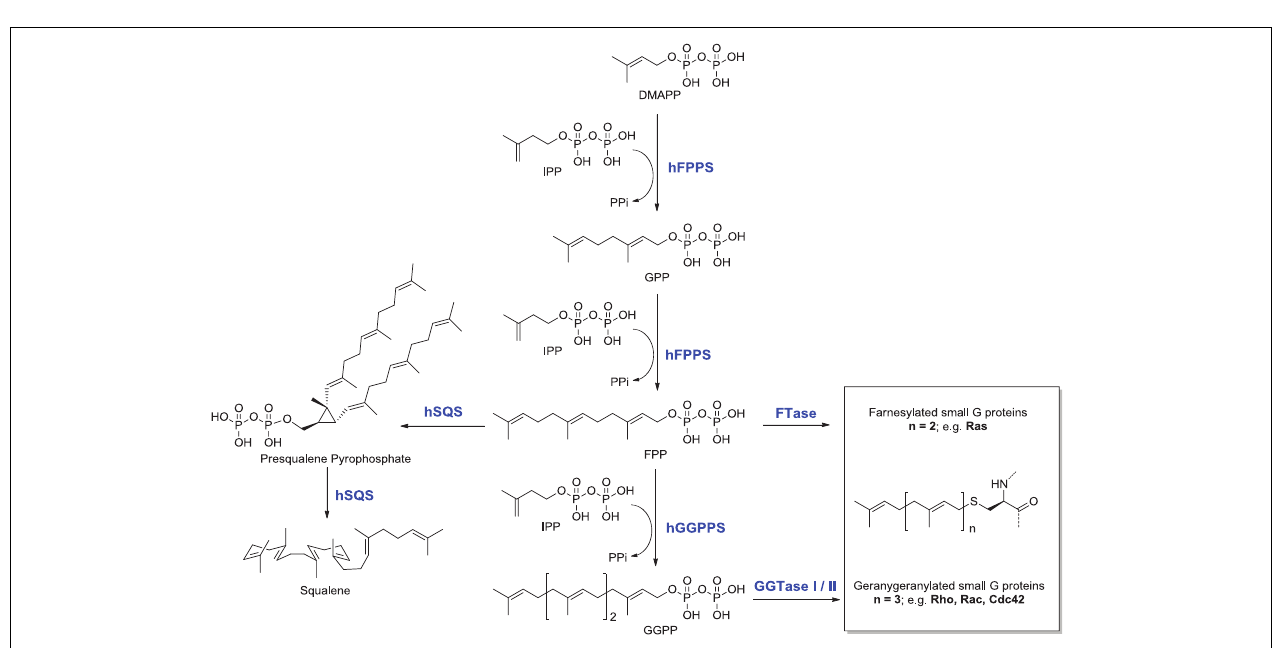
Bisphosphonates (indicated — ). FPPS, GGPS, and SQS enzymes are highlighted in green color boxes; other key enzymes are highlighted in gray color boxes.